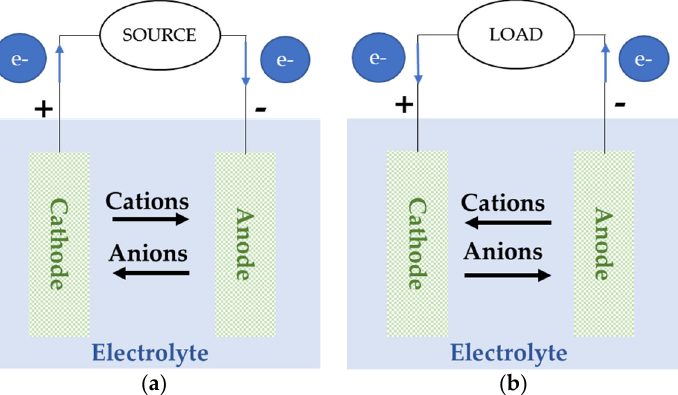
Figure 5. Cell configuration of a conventional battery during: ( a ) charge, ( b ) discharge.